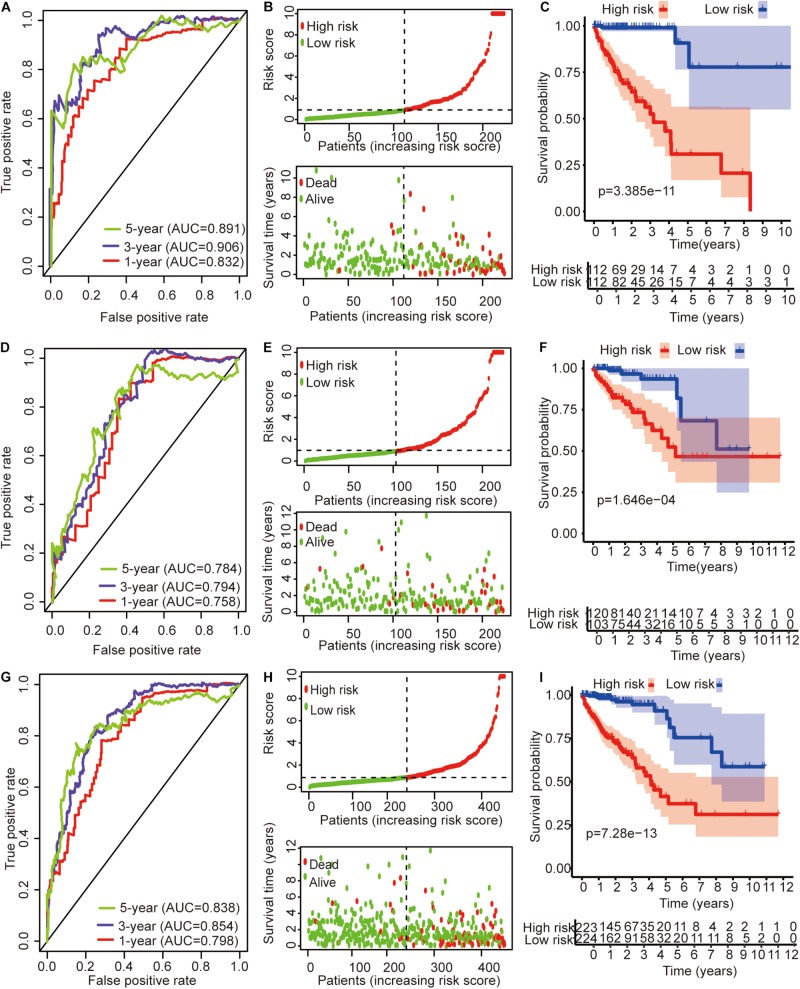
Time–ROC curve analysis, risk score analysis, and Kaplan–Meier curve survival analysis of the immune-related lncRNA signature in colon cancer. (A) Time–ROC curve analysis, (B) risk score, and (C) Kaplan–Meier survival curve of the immune-related lncRNA signature in the training cohort. (D) Time–ROC curve analysis, (E) risk score, and (F) Kaplan–Meier survival curve of the immune-related lncRNA signature in the testing cohort. (G) Time–ROC curve analysis, (H) risk score, and (I) Kaplan–Meier survival curve of the immune-related lncRNA signature in the entire TCGA cohort.